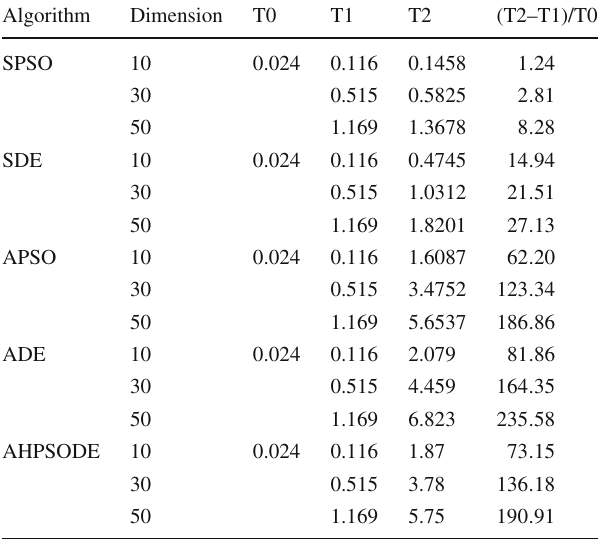
Table 6 Running-time complexity for SPSO, SDE, APSO, ADE, and AHPSODE